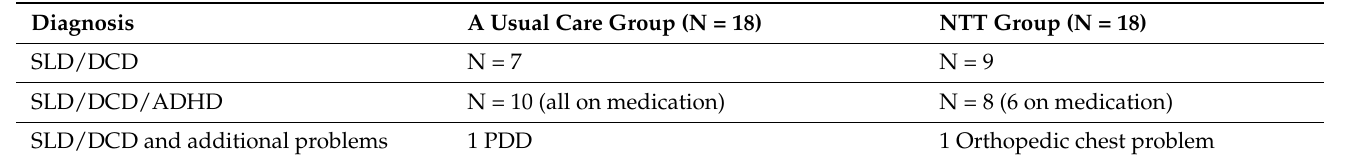
Table 1. All children included in the study had multiple diagnoses. SLD: Specific learning disorder, DCD developmental coordination disorder, ADHD attention deficit hyperactivity disorder, PDD pervasive developmental disorder, NTT Neuromotor Task